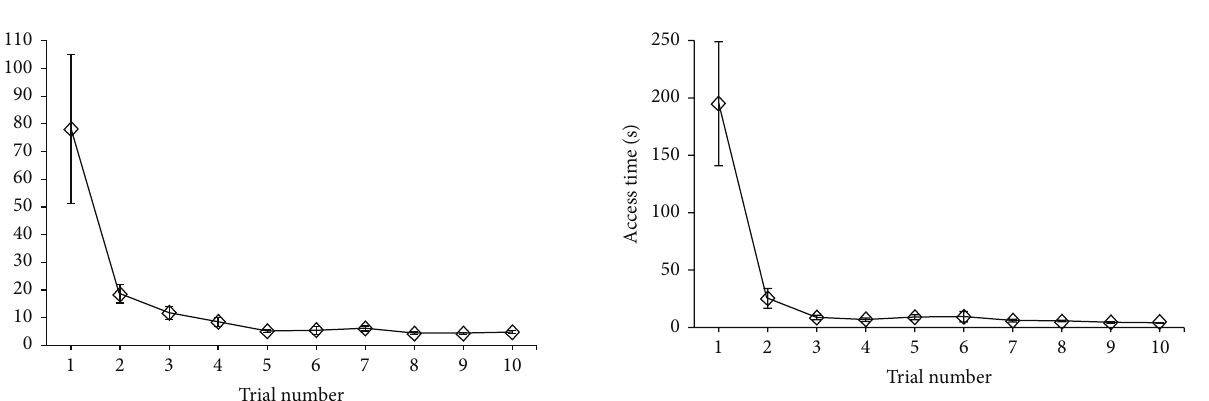
Figure 5: The learning curve (time/sec) ( ± SE) taken to access and forage on syrup for 9 workers of Bombus impatiens which were allowed to watch experienced foragers (from different colony (colony A)) at artificial flowers for 10 hours and held incommuni- cadoovernight.Inthemorningthesebeesdemonstratedtheirability to forage at the flowers after 3 trails. The flowers were replaced with cleaned ones after each of the first three trials and for each individual bee tested. The activities of the foragers were recorded for a further 7 visits. H 0 showing that the durations for successful foraging are independent of experience of having watched other, non-nestmate, bees forage is rejected ( 𝐹 8,9 = 7.7 ; 𝑃 < 0.001 ).